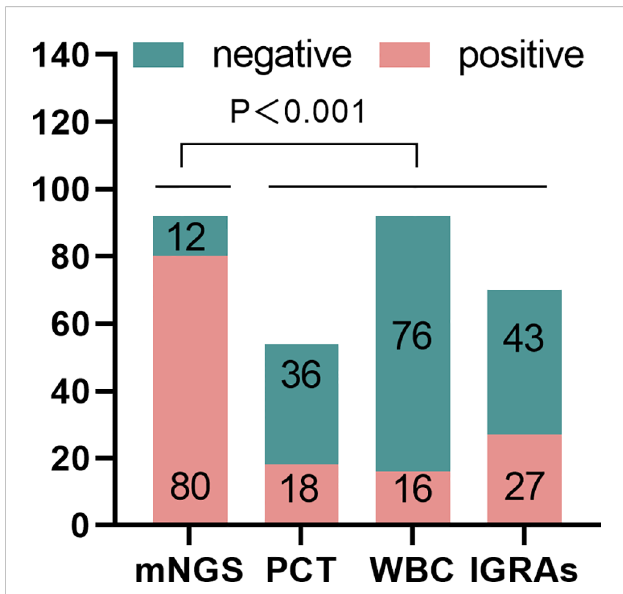
FIGURE 3 The positive rate of metagenomic next-generation sequencing (mNGS)for spinal infection pathogens was signi fi cantly higher than that of PCT, WBC, and IGRAs ( P < 0.001).PCT, procalcitonin; IGRAs, Interferon-gamma Release Tests.